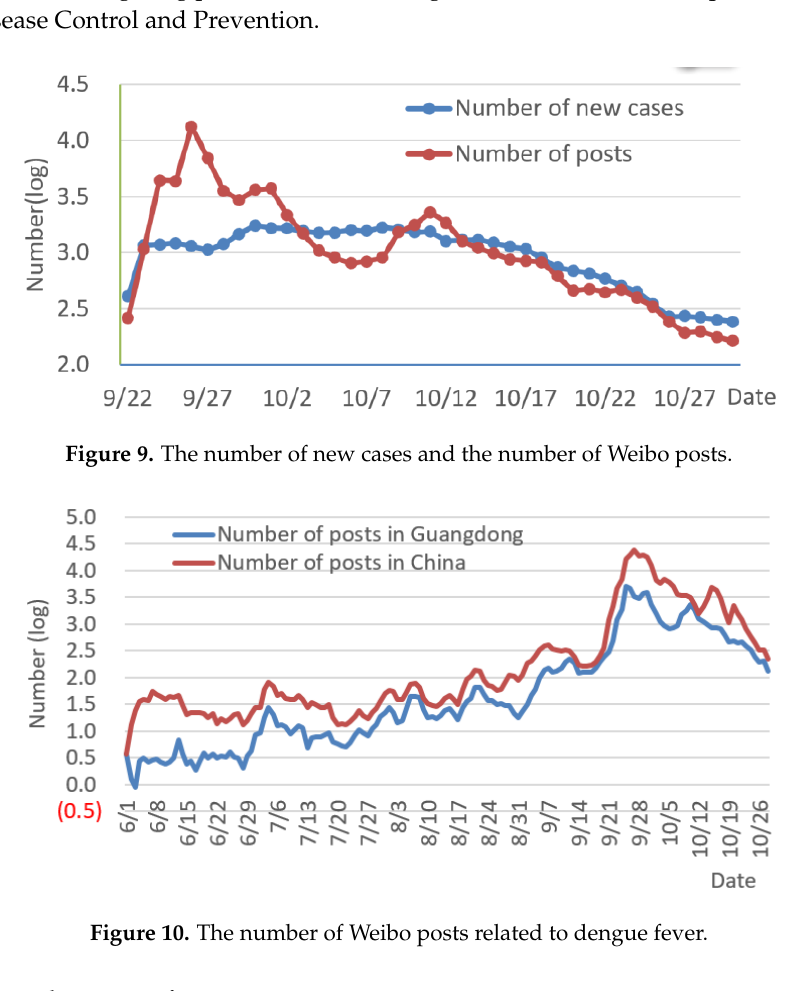
Figure 8. The trend on one day, 22 September 2014.